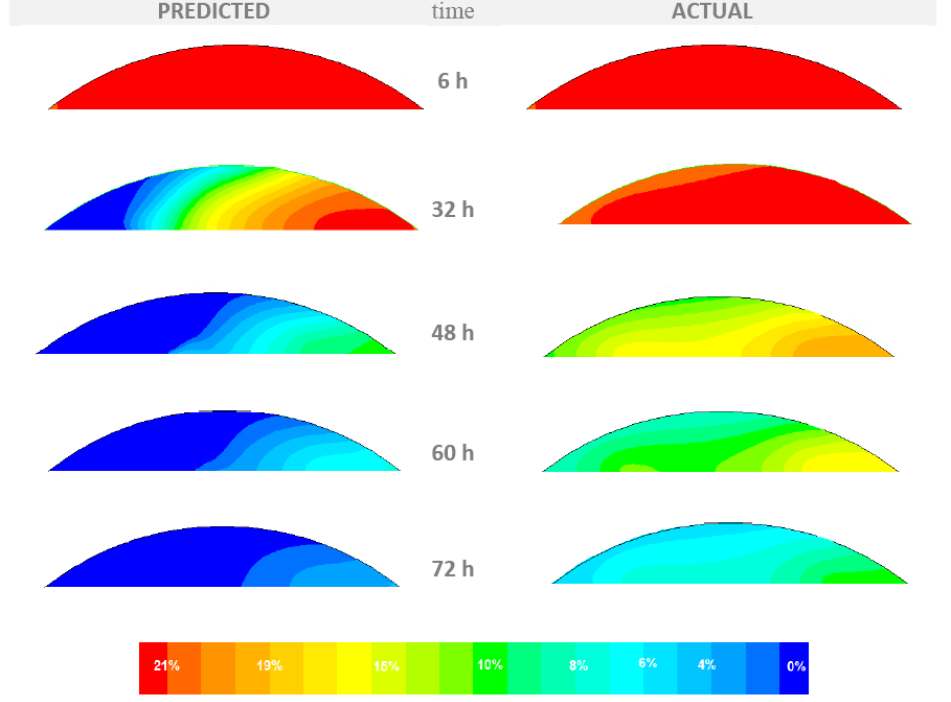
Figure 7. The predicted temporal distribution of the oxygen concentration (at the stack center) by the CFD model (left) and the actual according to the sensor